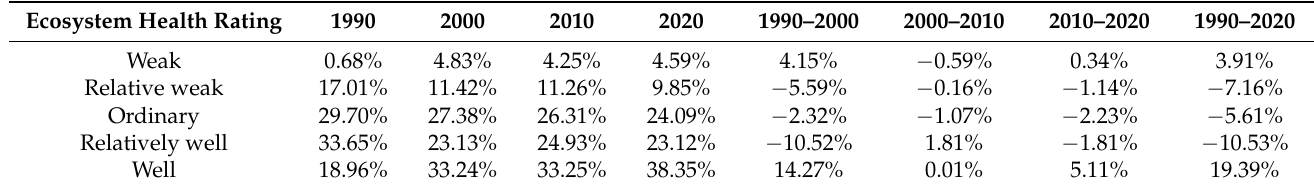
Table 5. Percentage area and amount of change of each class of EHI in central Yunnan urban group, 1990 – 2020.